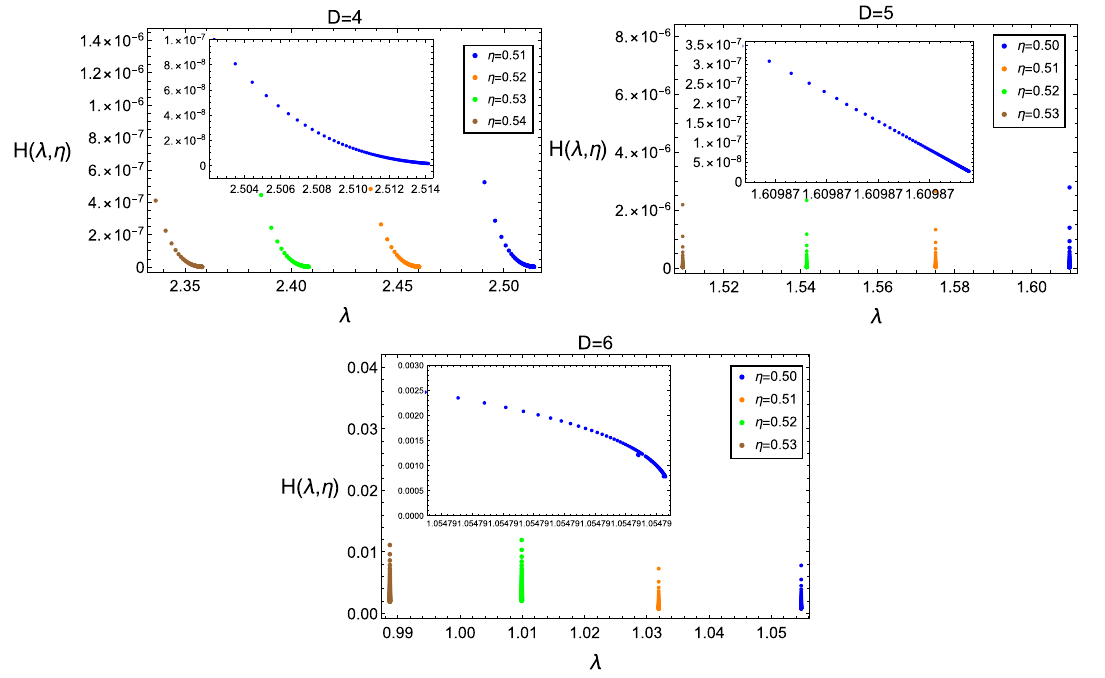
Fig. 5 The causal horizon entropy in the Schwarzschild BH for z (cid:13) 1 (IR behavior). The horizontal axis represents the affine parameter λ . We have set the parameters, m = 1 and (cid:9) AdS = 0 . 1, for the convenience of numerical calculations and plotting